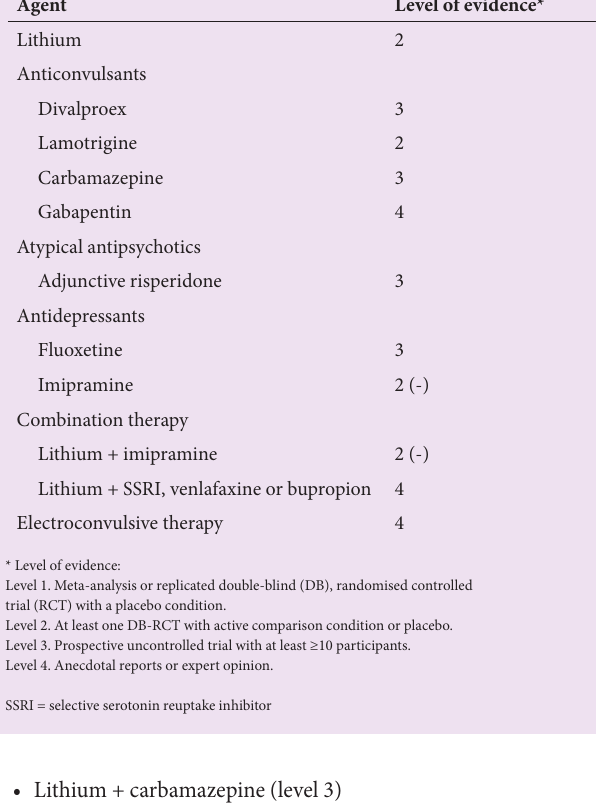
Table 5. Strength of evidence for the maintenance therapy of bipolar II disorder [1] Agent Level of